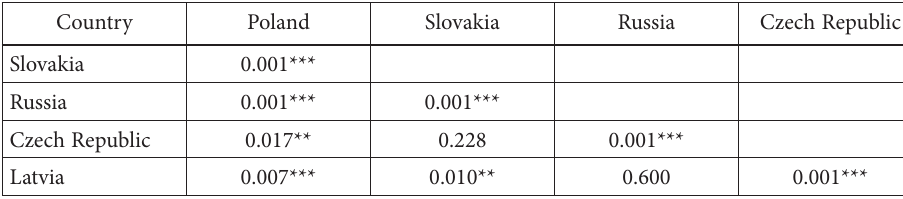
Table 7. Non-parametric bootstrap method p-values